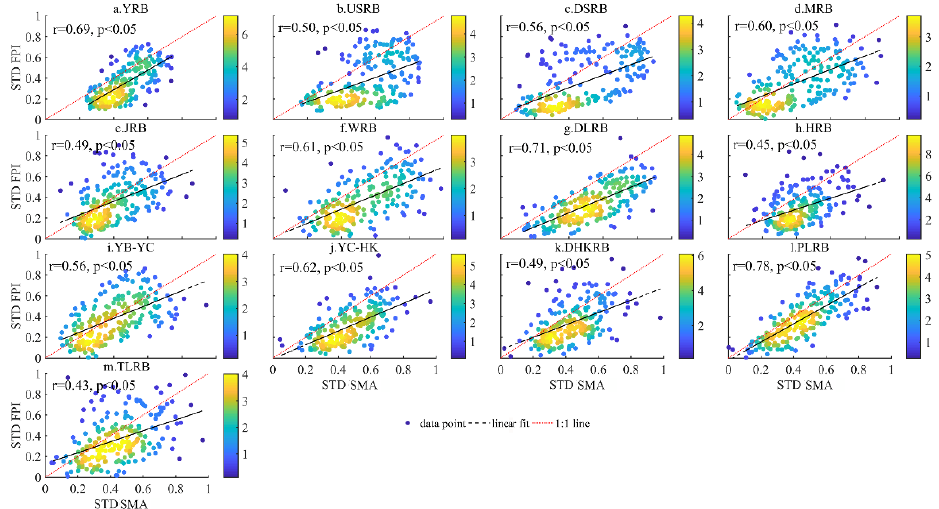
Figure 11. Kernel plot between standard FPI and VIC-SMA in the sub-basins of YRB during April 2002–December 2019.